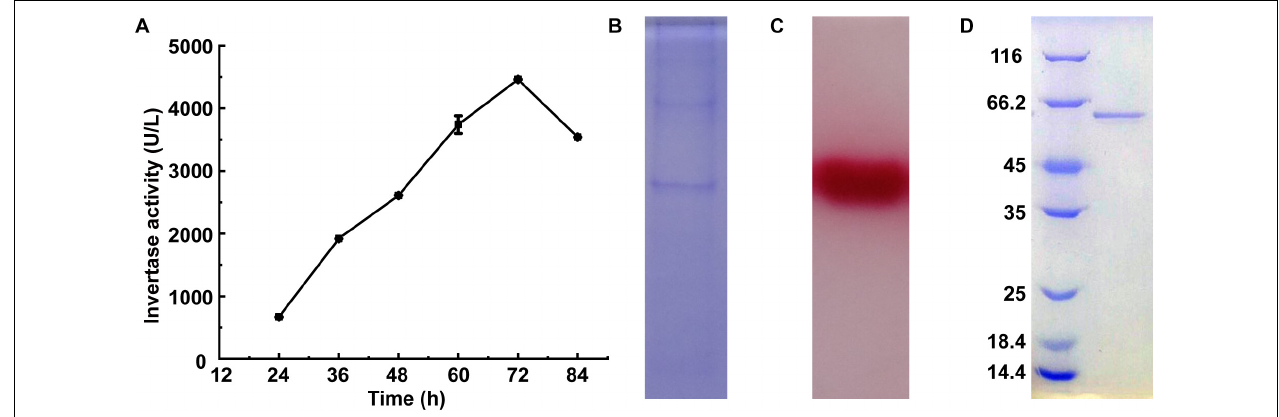
FIGURE 1 | Expression and purification of InvDz13. (A) Time course of invertase activity in culture supernatant of M. trichothecenolyticum Dz13. (B,C) Coomassie brilliant blue (B) and triphenyl tetrazolium chloride (C) stained 15% SDS-PAGE gel of InvDz13 in culture supernatant of M. trichothecenolyticum Dz13. (D) Coomassie brilliant blue stained 15% SDS-PAGE gel of InvDz13 after ion-exchange column and gel filtration column purification.